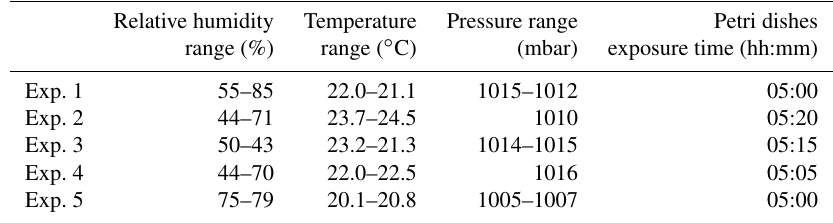
Table 1. Environmental parameters (RH, T , P ) in ChAMBRe during the experiments with B.subtilis . Relative humidity Temperature Pressure range Petri dishes range (%) range ( ◦ C) (mbar) exposure time (hh:mm)